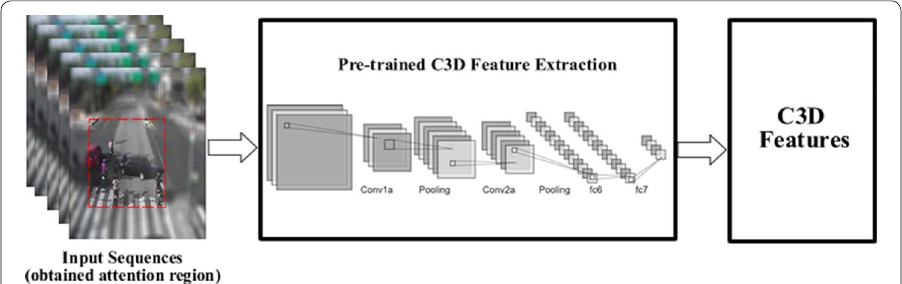
Fig. 6 Pre-trained C3D feature extraction of obtained attention